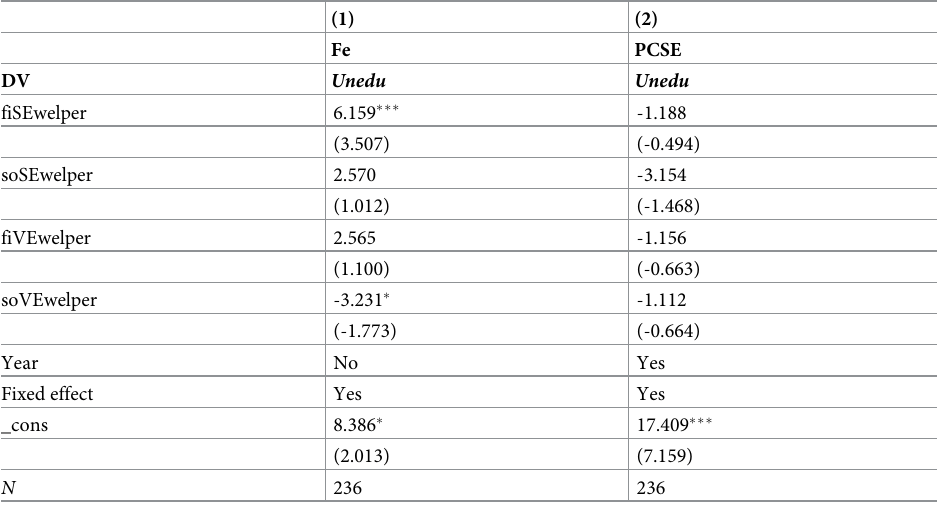
Table 13. The results of welfare expense on RSE correction with RVE.